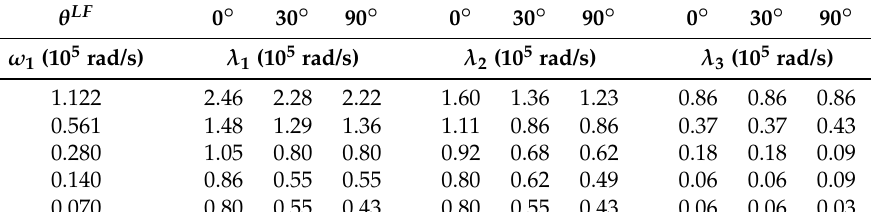
Table 1. Set of characteristic angular velocities ( λ 1 , λ 2 , λ 3 ) detected by multi-quanta spin-locking relaxometry for 2 H NMR experiments obtained by varying the irradiation power ω 1 and the angle θ LF (see text).